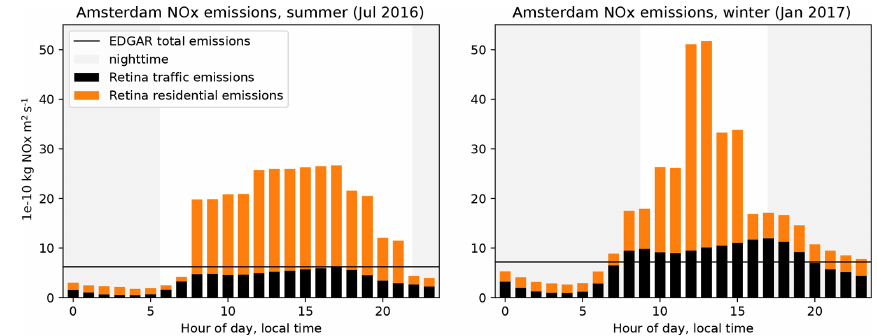
Figure 5. Diurnal emission cycles after calibration of emission factors in different